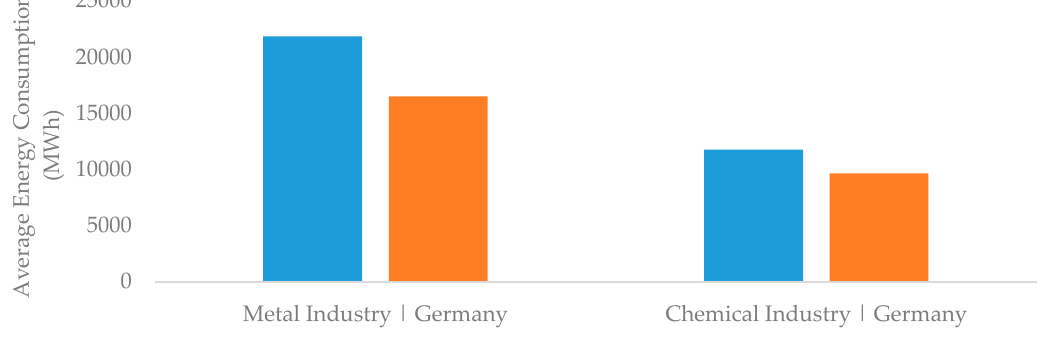
Figure 8. Potential savings in energy consumption for each approached industrial sector in Germany (data adapted from [35,36,43]).